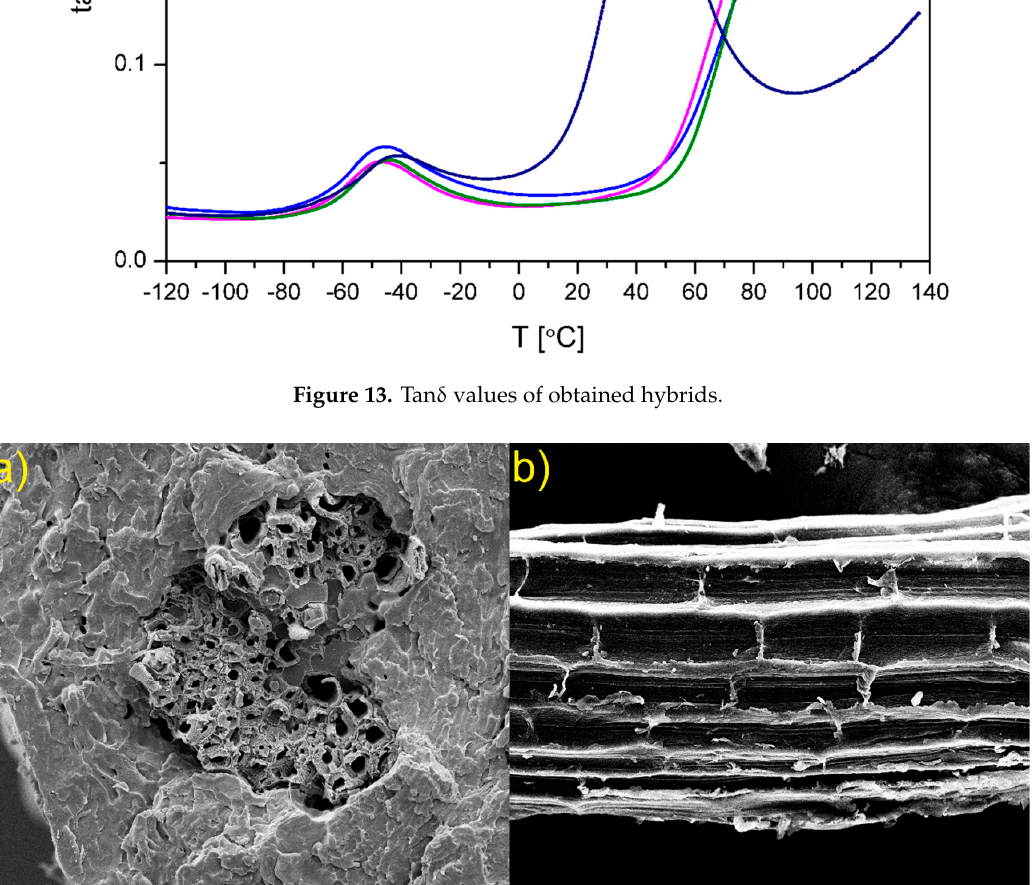
Figure 14. SEM images of sisal fiber ( a ) transversal cross-section of sisal in material; ( b ) longitudinal section of sisal.